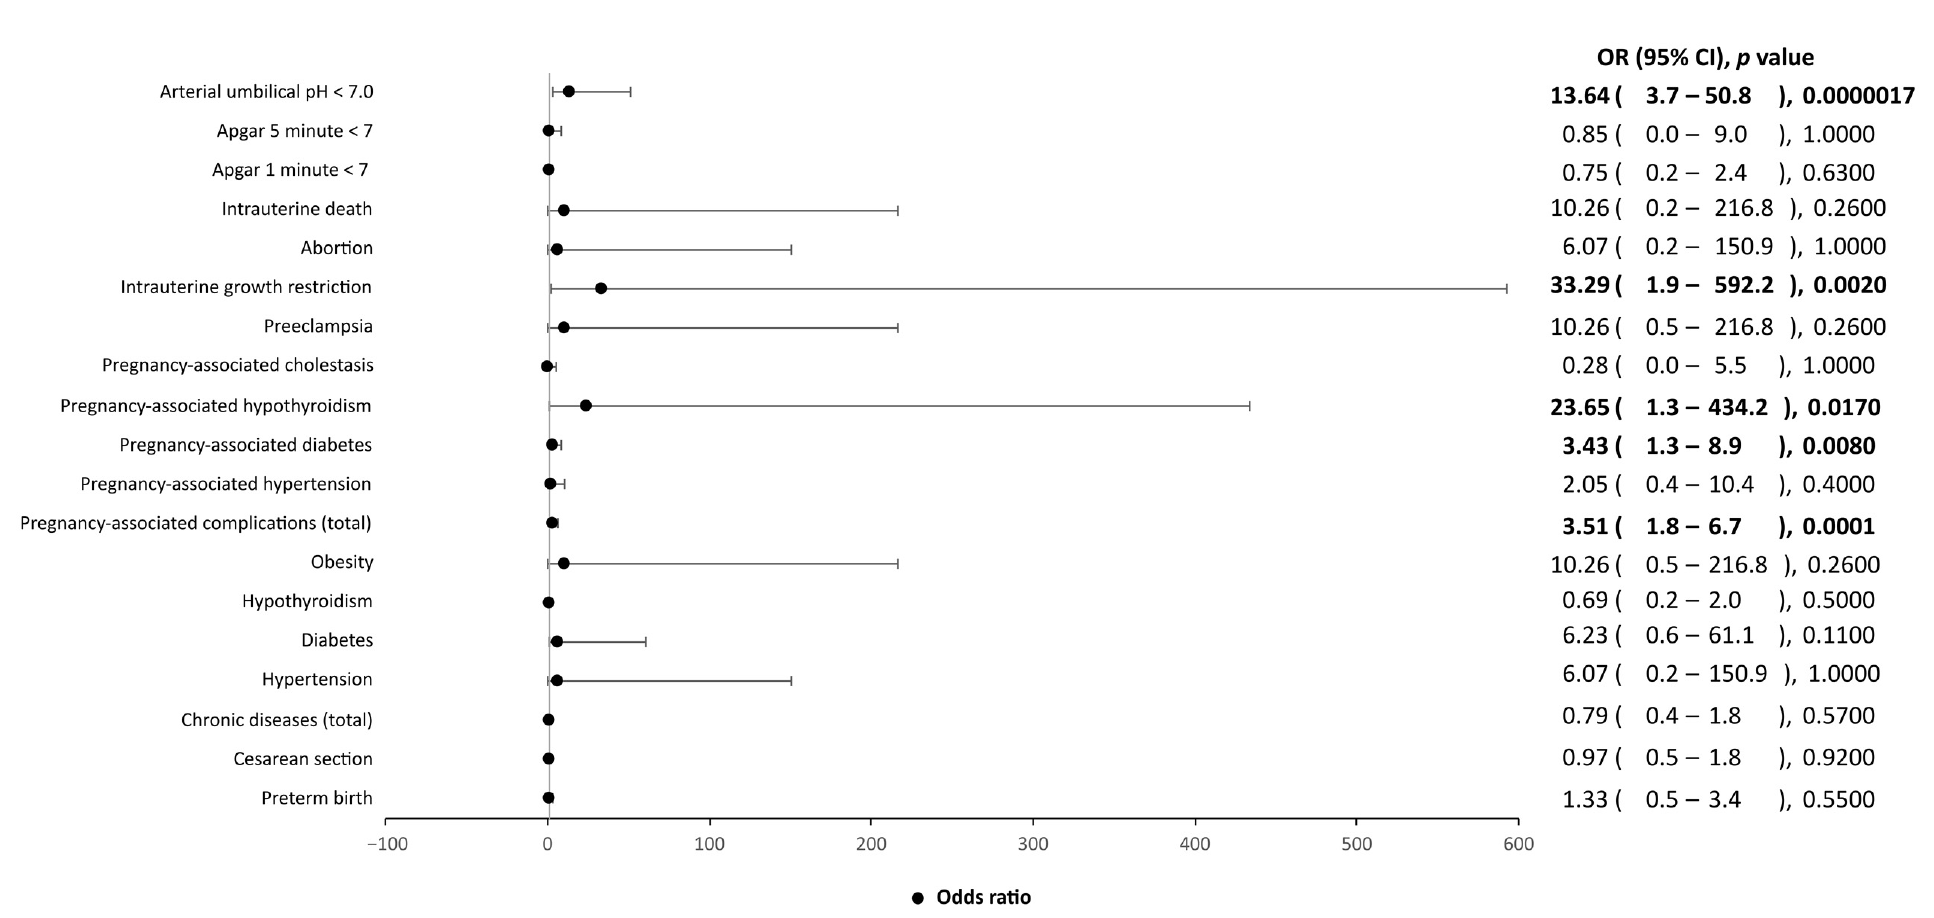
Figure 1. Influence of clinical factors, including chronic diseases, pregnancy-associated complications and Apgar scores, on SARS-CoV-2-positive mothers and their children, as compared to SARS-CoV-2-negative mothers and their children. OR, odds ratio; CI, confidence interval. Values in bold indicate statistical significance, as the level of statistical significance was set to p < 0.05.